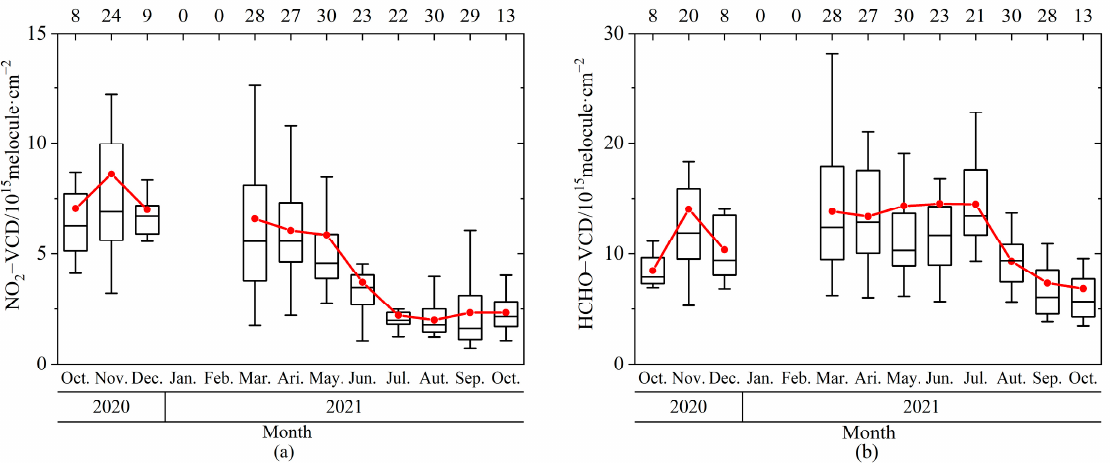
Figure 5. Monthly tropospheric VCDs (Unit: 10 15 molecule·cm − 2 ) for ( a ) NO 2 and ( b ) HCHO. The upper (lower) error bars and upper (lower) boundaries of the boxes are the 95th (5th) and 75th (25th) percentiles of the data grouped per month, respectively. The lines inside the boxes and the red curves with dots indicate the medians and the averages, respectively. The number of sampling days per month is marked on the top axis.